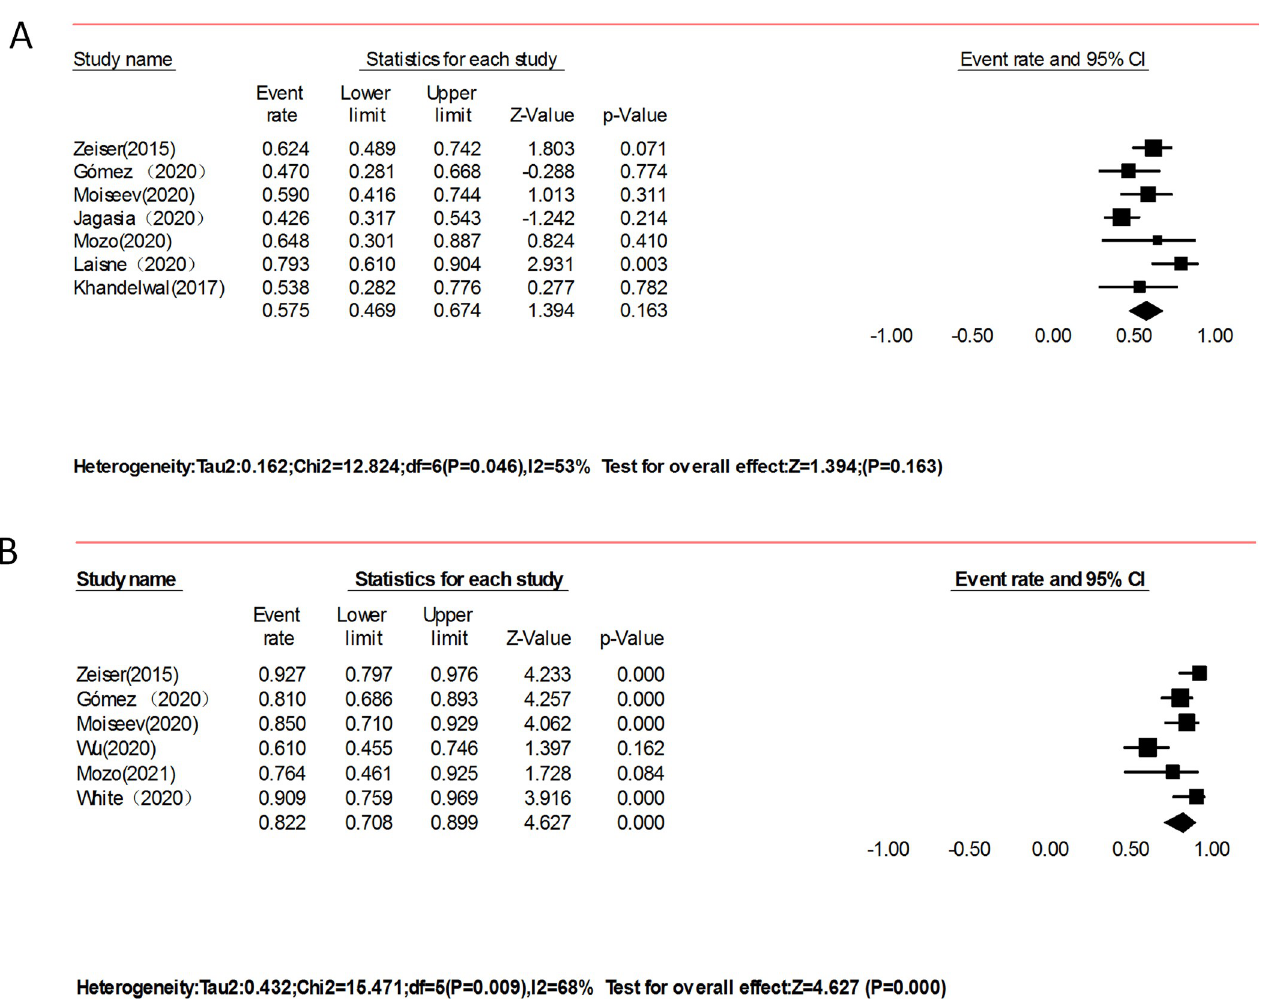
Fig 3. Forest plots of overall survival with 95% CI. Random effect models were